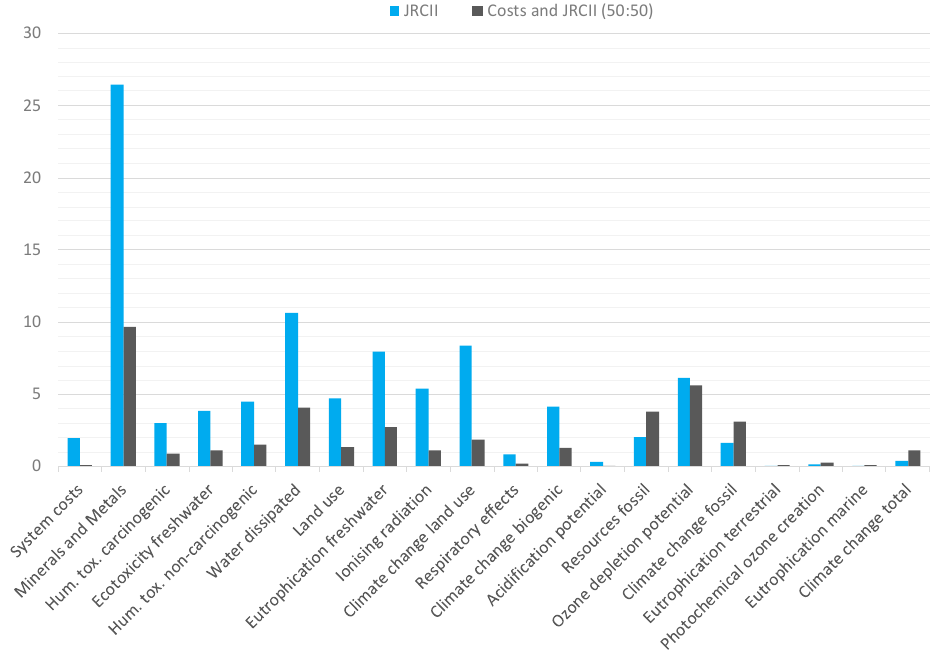
Figure 6. Normalised distance from the minimum for each single optimisation objective under multi-objective optimisation.